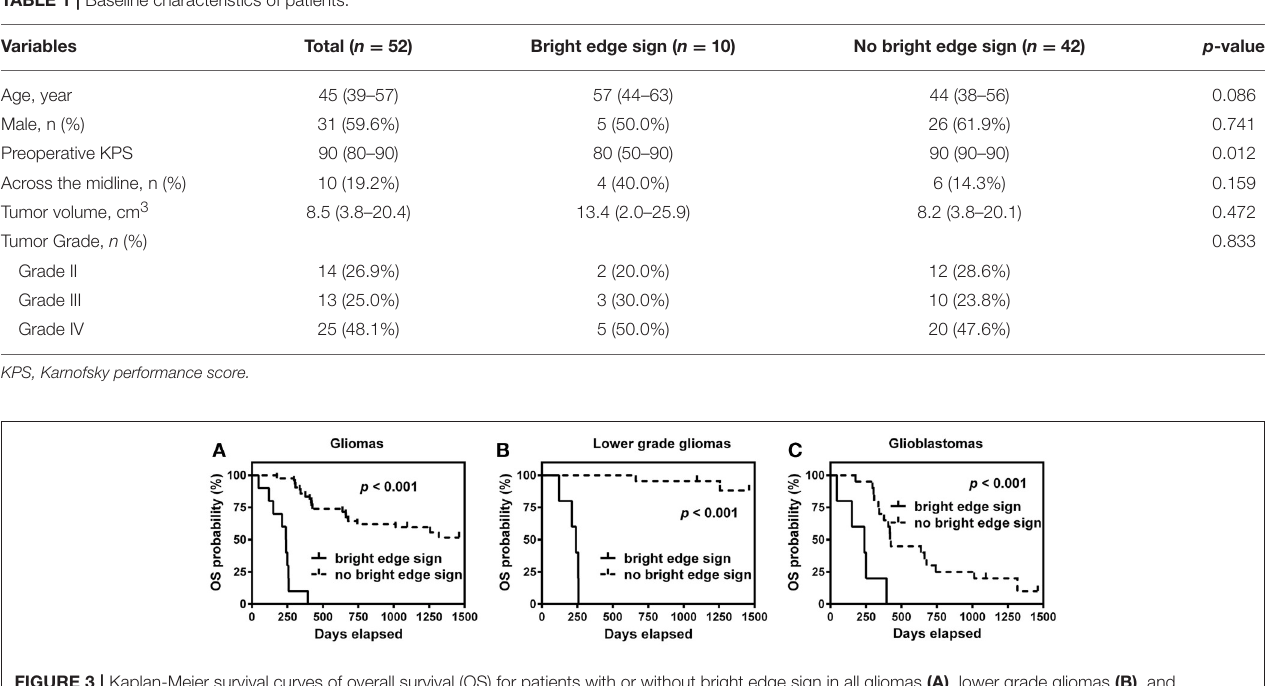
FIGURE 3 | Kaplan-Meier survival curves of overall survival (OS) for patients with or without bright edge sign in all gliomas (A) , lower grade gliomas (B) , and glioblastomas (C) .